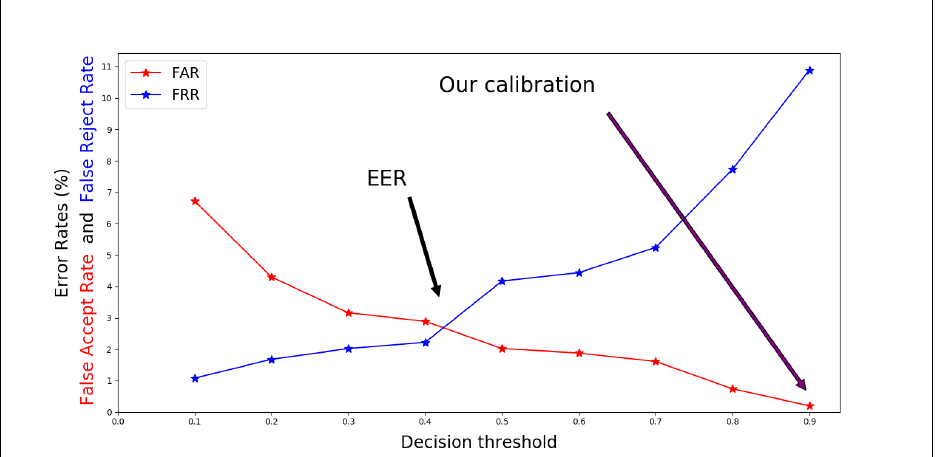
Figure 9. Evaluation RFF calibration by low